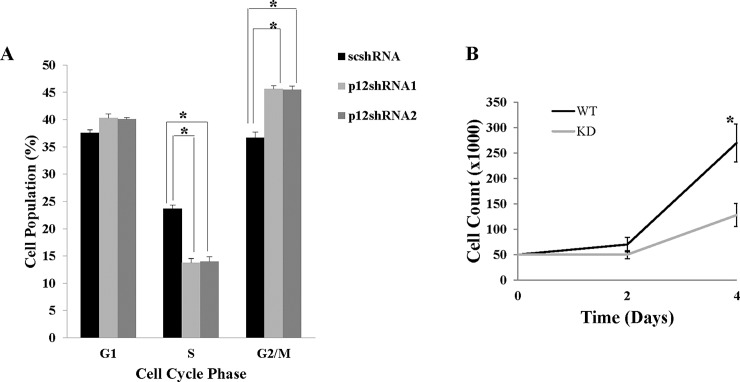
Knockdown of CDK2AP1 in hESC reduces proliferation and increases cells in the G2/M and decreases cells in the S phase of the cell cycle.A. Fifty thousand WA09 hESCs that were transduced with a scshRNA (WT) or CDK2AP1 shRNA1 (KD) were seeded per well in a 12-well plate. Cells were harvested and counted in triplicates at 2 and 4 days post seeding. (*- p-value < 0.05). Comparisons were made between WT and KD cells at respective time points). Results are presented together with standard deviation from experiments conducted in triplicate. B. CDK2AP1 wild type and knockdown WA09 hESCs were harvested and equal numbers were stained with propidium iodide (PI) and analyzed using an Accuri C6 flow cytometer. Results are presented together with standard deviation from experiments conducted in triplicate. (* = p < 0.05).